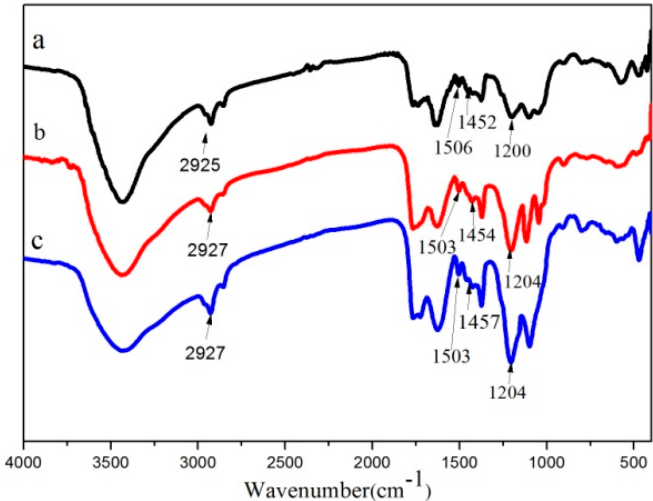
Figure 4. FTIR spectra of D-WSAL prepared with 2.5 mL ( a ), 4 mL ( b ), and 5.5 mL ( c ) DMF with 12:1 molar ratio of ICH to lignin, at 145 °C for 3 h under nitrogen atmosphere. Table 2. Relative values of functional groups on D-WSAL prepared with 2.5 mL, 4 mL, and 5.5 mL DMF with 12:1 molar ratio of ICH to lignin, at 145 °C for 3 h under nitrogen atmosphere. (Phenyl group’s skeleton vibration peak at 1503 cm − 1 was selected as the reference, the relative values of other groups by area ratios of the peaks were calculated.)